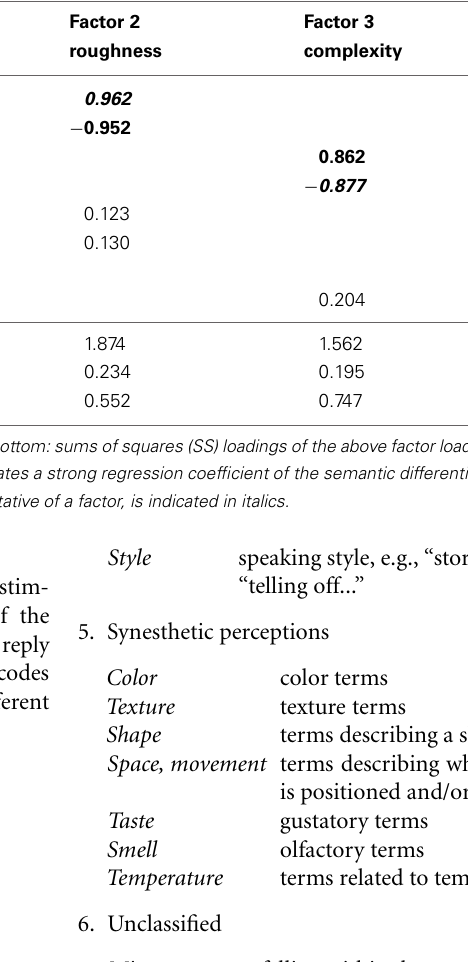
Table 3 | Factor analysis with promax rotation of texture rating data.